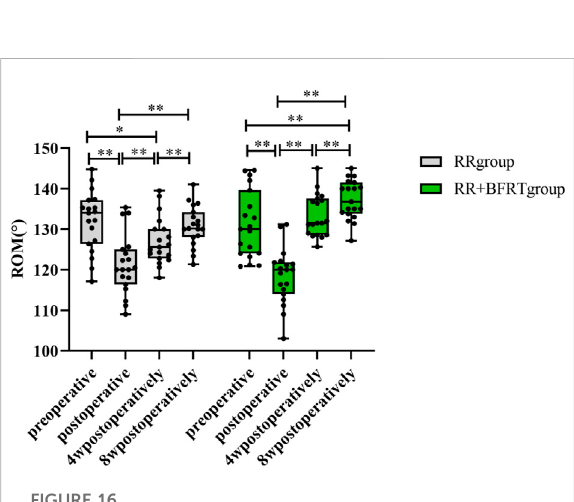
FIGURE 16 Intra-group comparison of knee ROM in RR group and RR + BFRT group. “ ** ” indicates a signi fi cant change ( p < 0.01). Values are presented as mean ± SD. RR Group: routine rehabilitation group; RR + BFRT Group: routine rehabilitation + blood fl ow restriction training